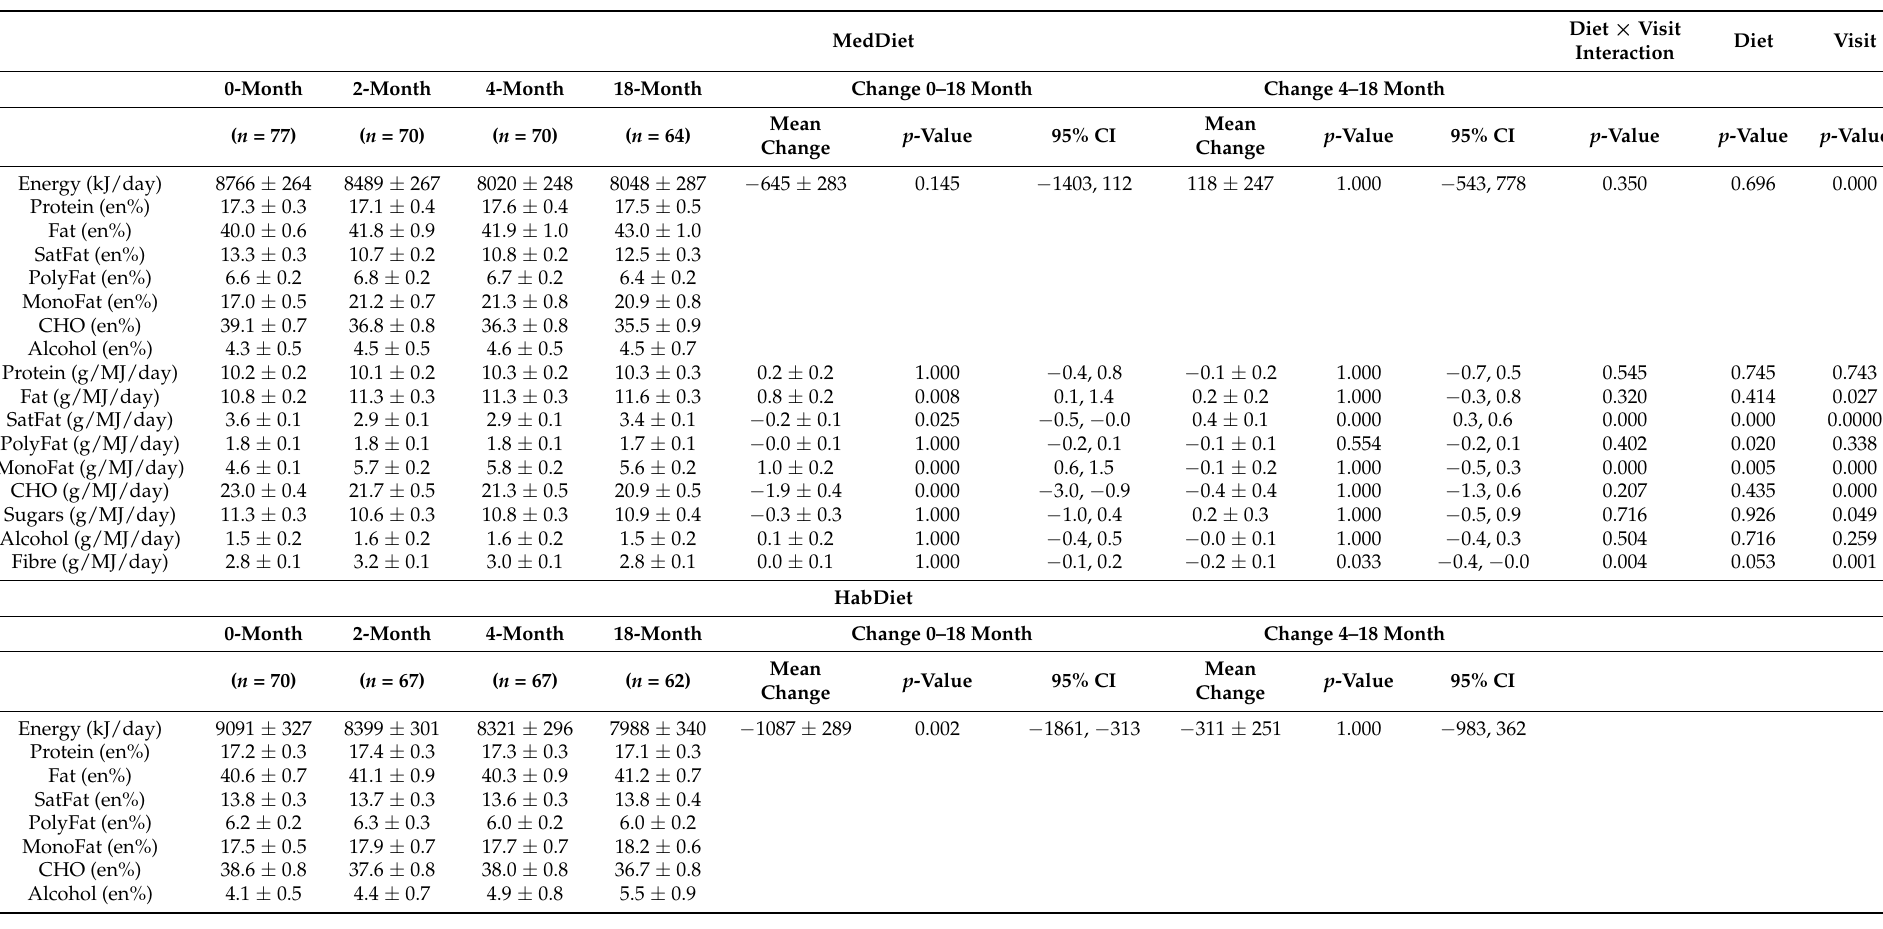
Table 3. Daily nutrient intake at baseline (0 months) and during 6-months dietary (measured at 2 and 4 months) intervention and 12 months after intervention ceased (18